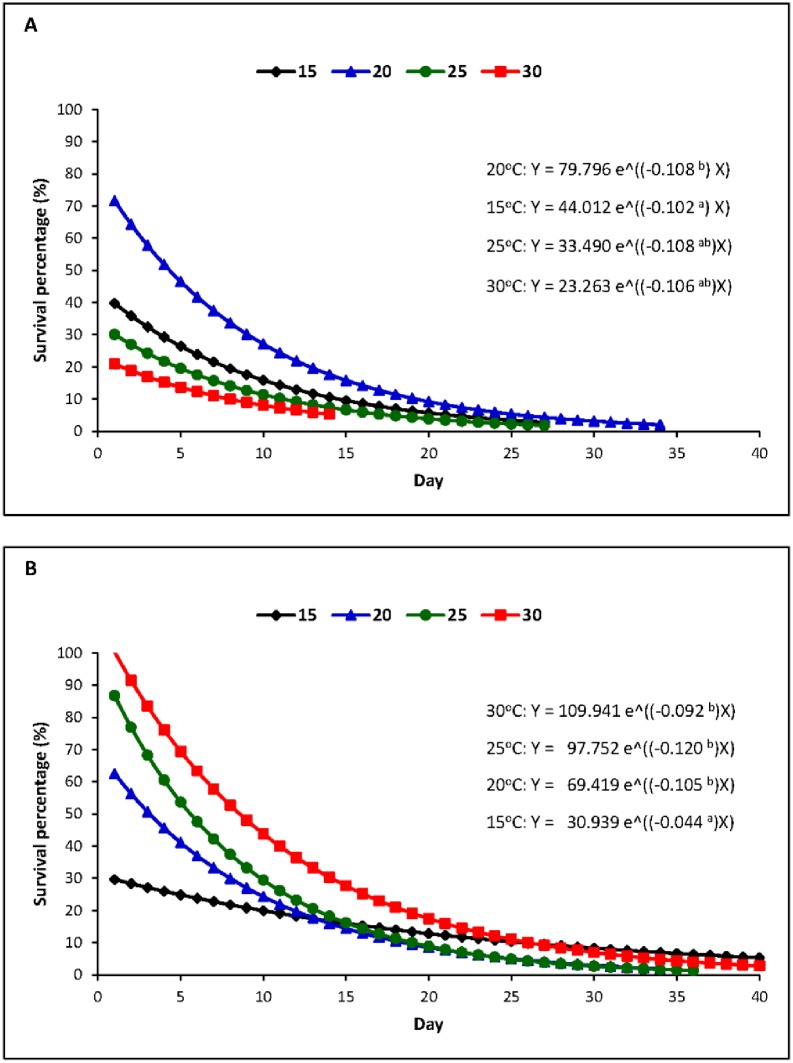
Survival curves at different temperatures.A, B. kugenumaensis. B, E. braueriana. Different superscript letters (a, b) indicated the significant pairwise groups of different temperatures by post hoc analysis.